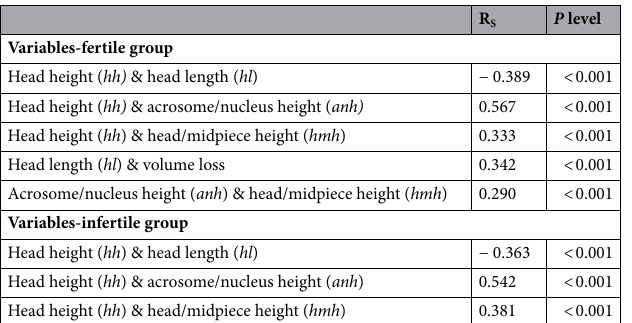
Table 4. Spearman order rank correlation between mean values of morphological sperm parameters obtained by DHM in the studied subgroups.